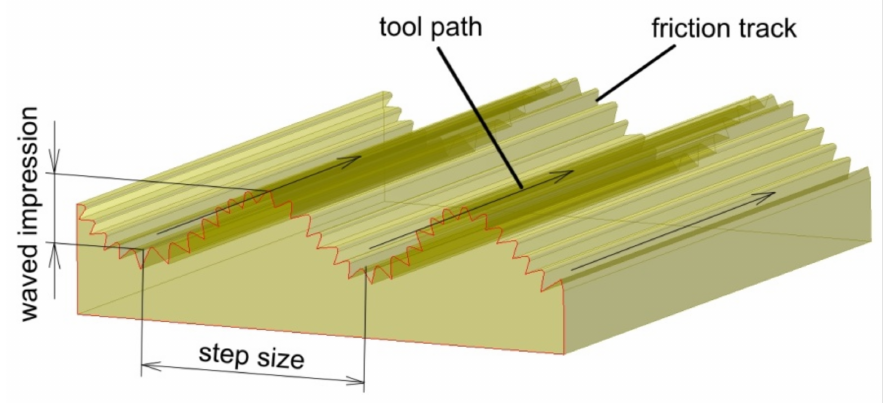
Figure 4. Surface of the drawpiece across the tool